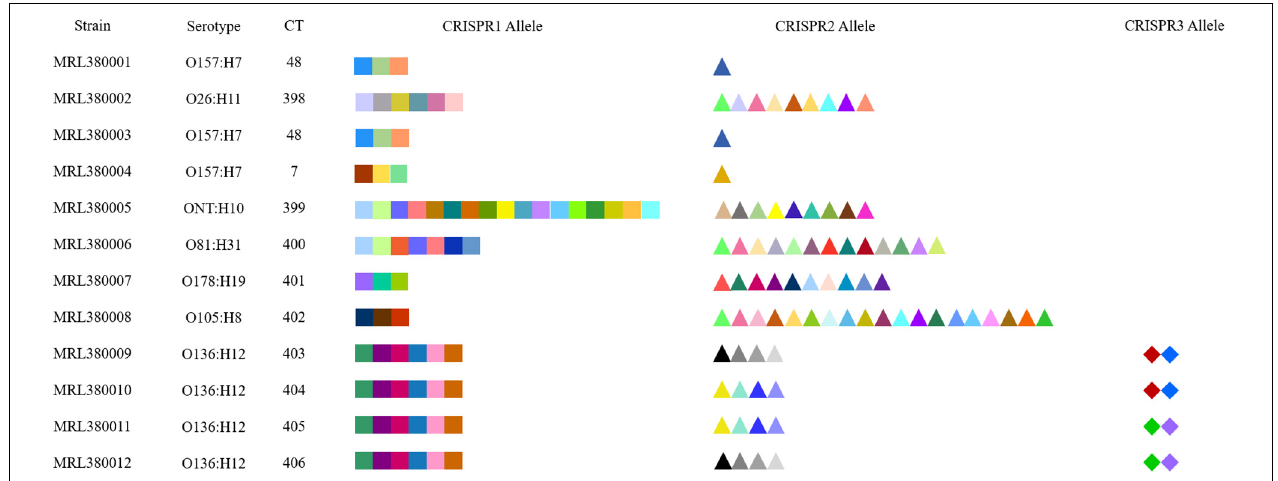
FIGURE 3 | CRISPR spacer arrangements of STEC strains. Elements with different colors and shapes represent different spacers.